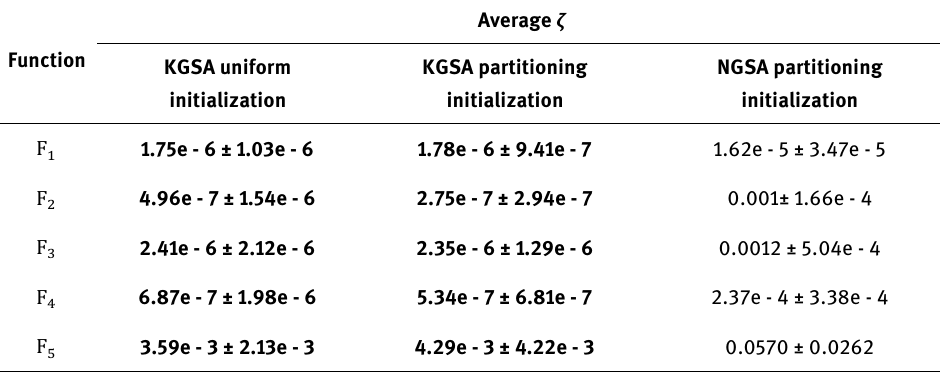
Table 5: The mean error ζ obtained with the KGSA and NGSA using N =20, T